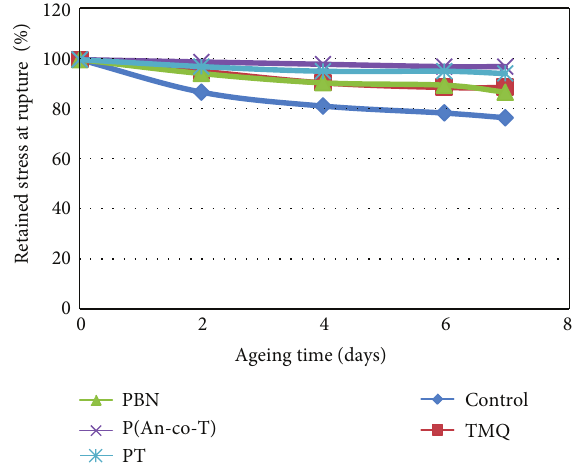
Figure 9: Retained stress at rupture versus ageing time for SBR vulcanizates.